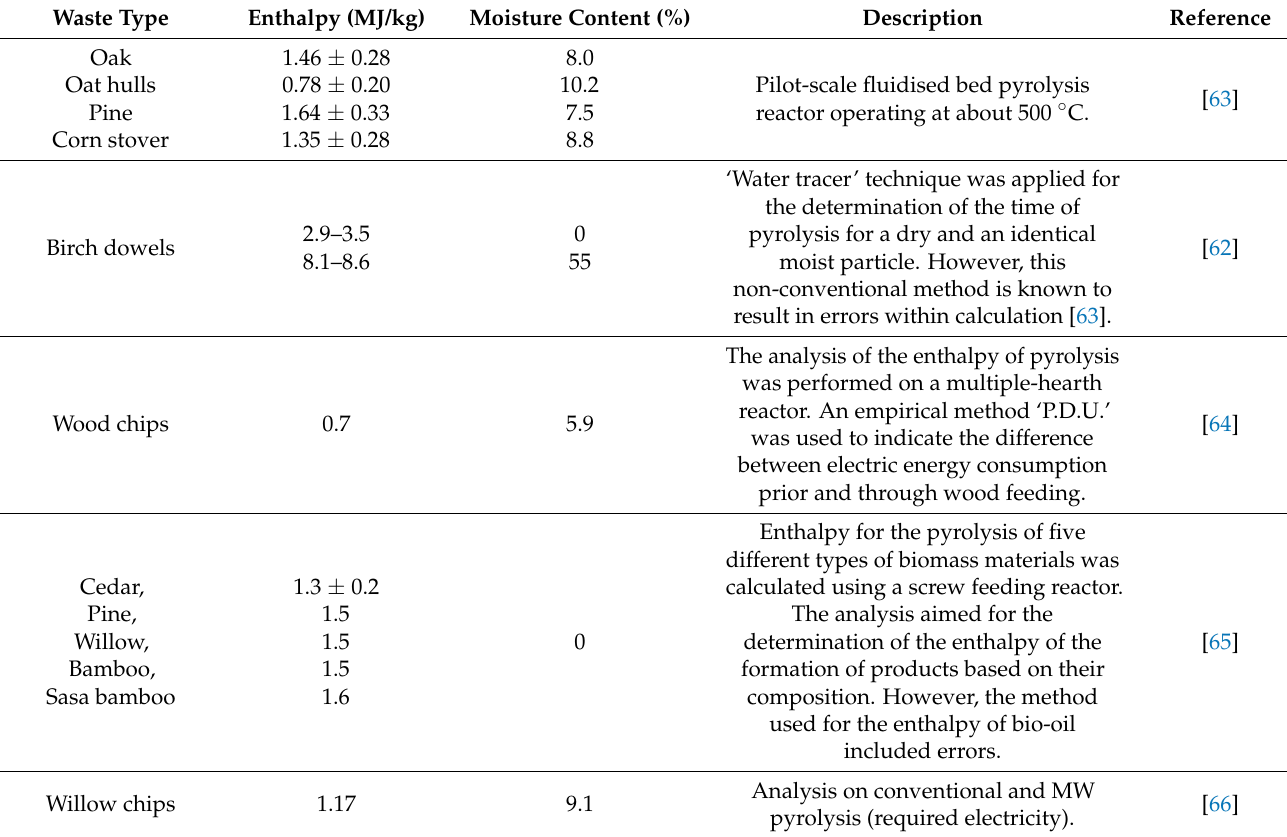
Table 3. Enthalpy values and net energy assumptions for the pyrolysis of various biomasses and sewage sludges. Waste Type